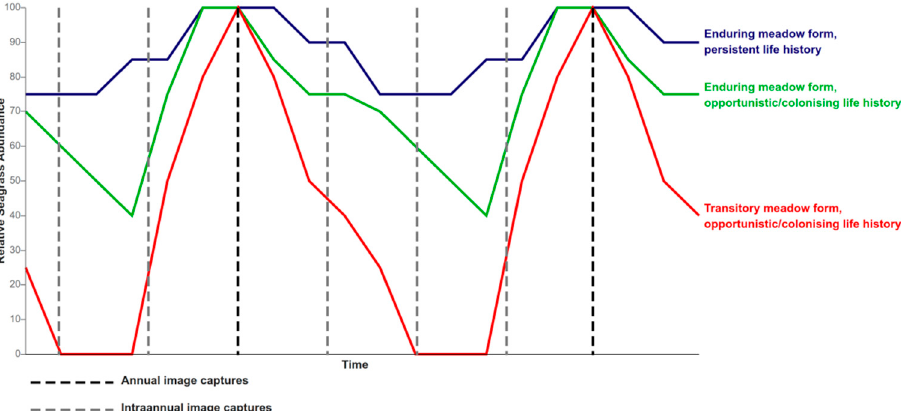
Figure 3. Conceptual comparison of different seagrass life cycles, highlighting the differences in representation between annual and intra-annual capture of remote sensing images. Indicative seagrass life cycles adapted from [61].